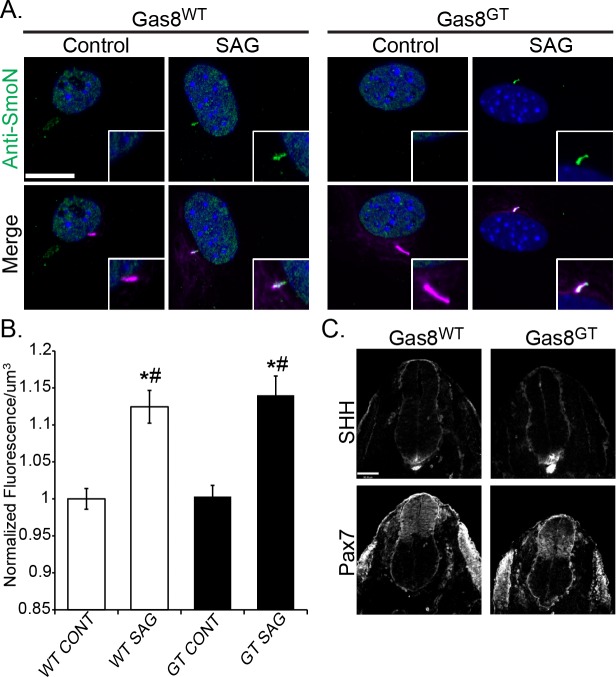
Gas8 mutant embryos have no overt Hh phenotypes.(A) Vehicle (Control) and drug treated (SAG) Gas8WT and Gas8GT mutant MEFs stained for Smo (green) and acetylated tubulin (purple). Scale bar is 15μm. (B) Quantification of Smo translocation into the cilium. All bars are normalized to WT CONT. (* = significantly different than WT CONT, # = Significant different than GT CONT p<0.05). (C) Gas8WT neural tube sections and Gas8GT sections. The Pax7 and Sonic hedgehog (SHH) domains in the notochord, floor plate and neural tube all appear similar between Gas8GT and Gas8WT littermates. Scale is 90μm.